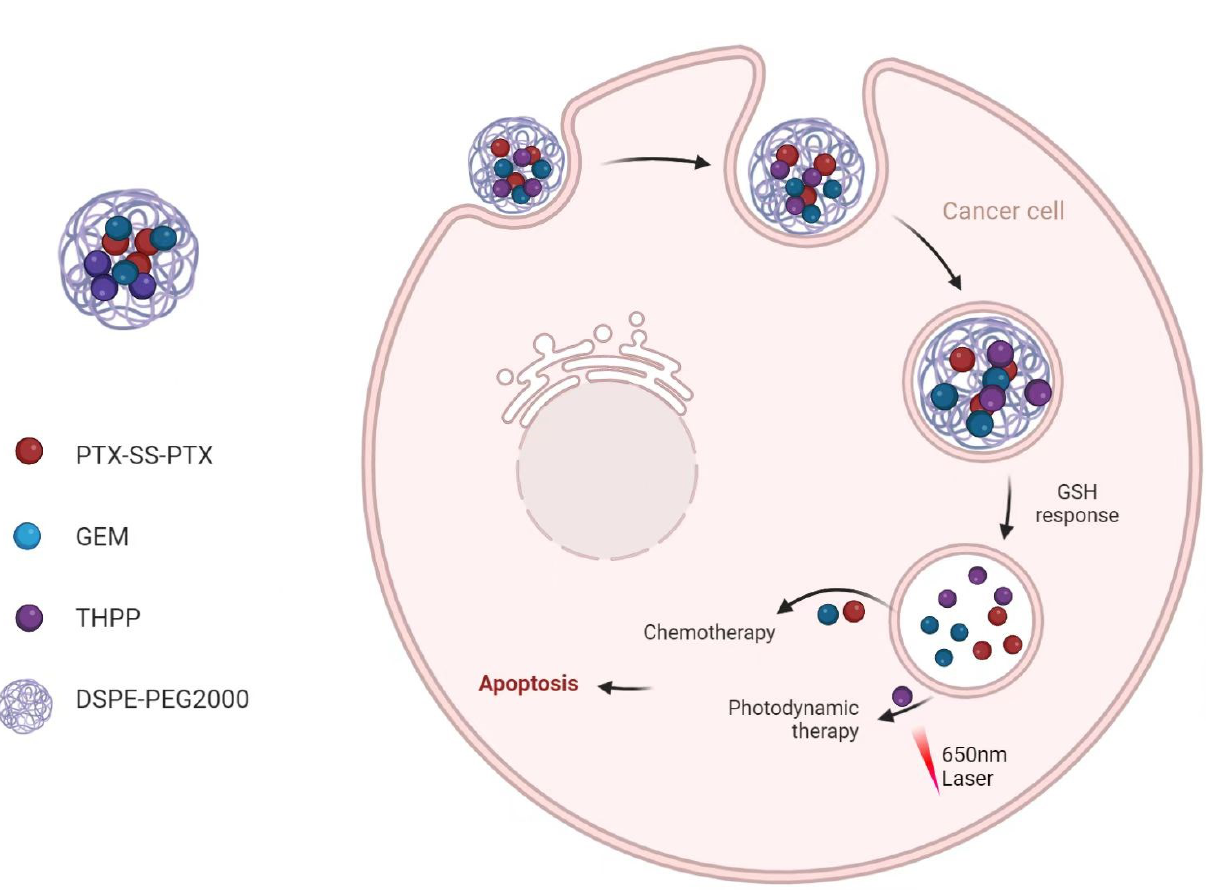
Scheme 1. Schematic representation of TPG NPs preparation and drug release inside a pancreatic cancer